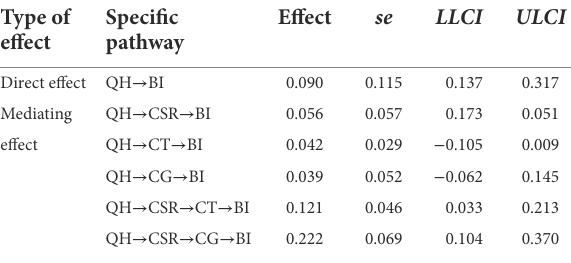
TABLE 2 The pathway mediating the influence on QH BI of potential